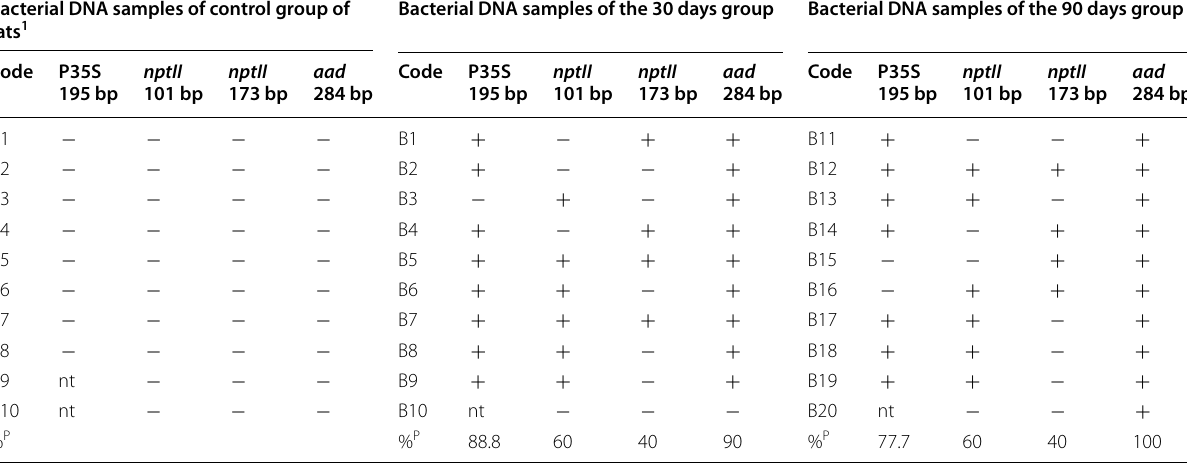
1 Bacterial cells collected from control rats shortly before weaning nt not tested, % P : percentage of transfer of GM sequences